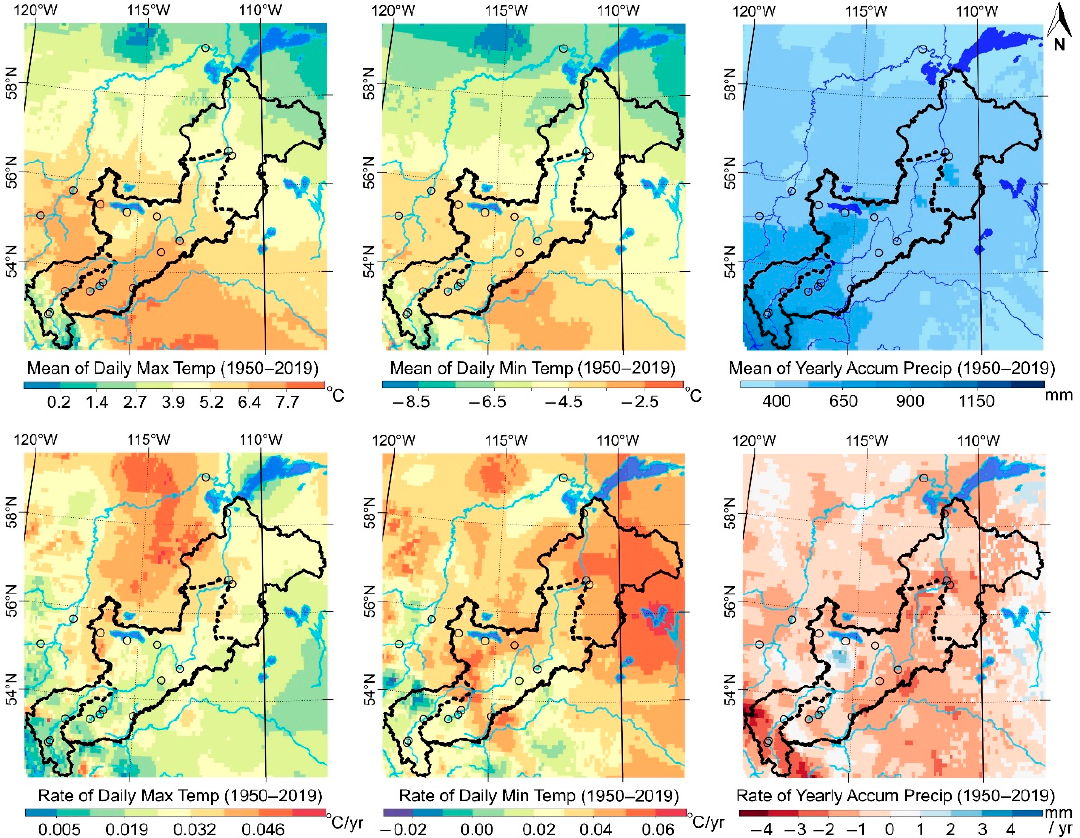
Figure 2. Spatiotemporal maps for daily maximum and minimum temperatures and yearly accumu- lated precipitation since 1950 (top three panels show the climate mean, and bottom three panels show the rates of change since